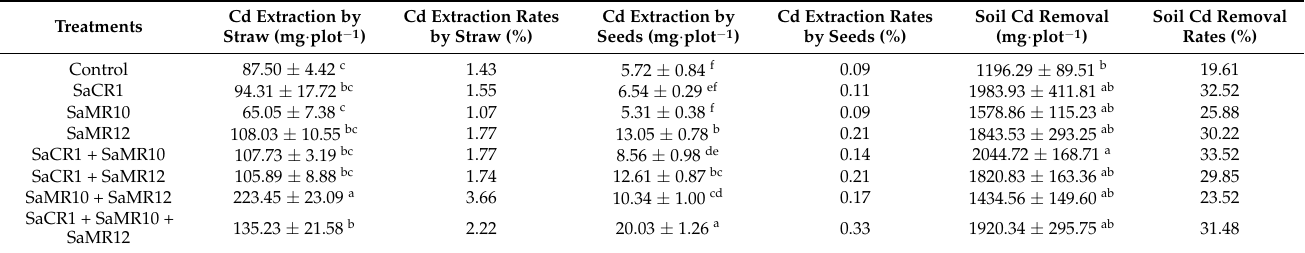
Table 2. Effects of PGPB inoculants on plant Cd extraction and soil Cd removal. The letters a–f represent the significant level among different treatment at p <